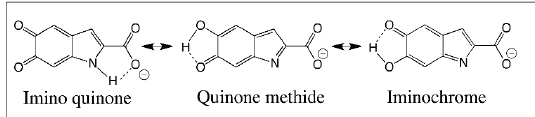
Figure 23. Two-electron oxidation products of DHICA. Two electron oxidation of DHICA will produce imino quinone, quinone methide and iminochrome products.